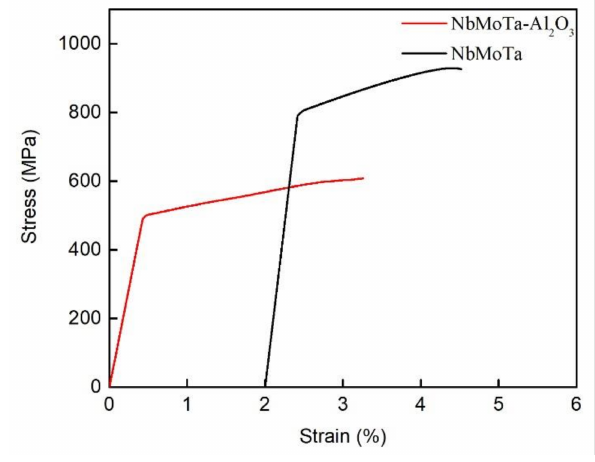
Figure 8. The compressive stress-strain curve of the NbMoTa–Al 2 O 3 composite structure. A 11.7 × 11.6 × 8.7 mm 3 NbMoTa–Al 2 O 3 composite structure square was deposited.